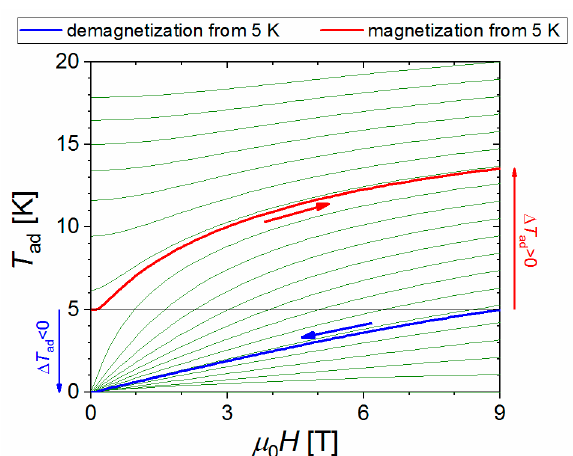
Figure 13. Temperature dependence of ∆ T ad of 2 .